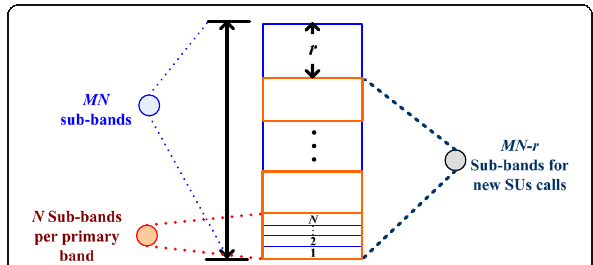
Fig. 1 Block diagram of the resource allocation strategy